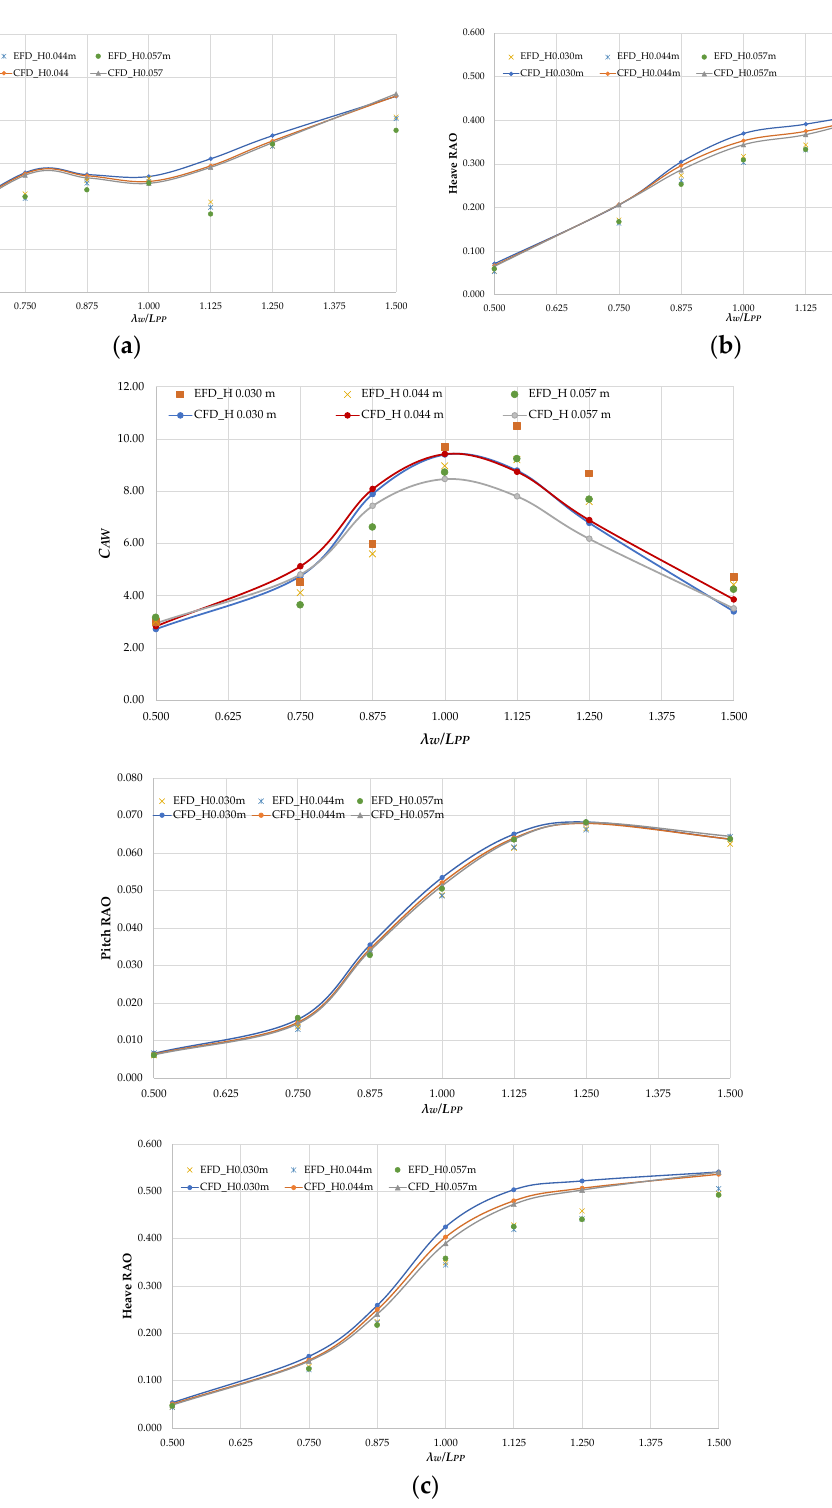
Figure 8. EFD and CFD Results for: ( a ) 𝐹 𝑅 = 0.131; ( b ) 𝐹 𝑅 = 0.174; ( c ) 𝐹 𝑅 = 0.218.